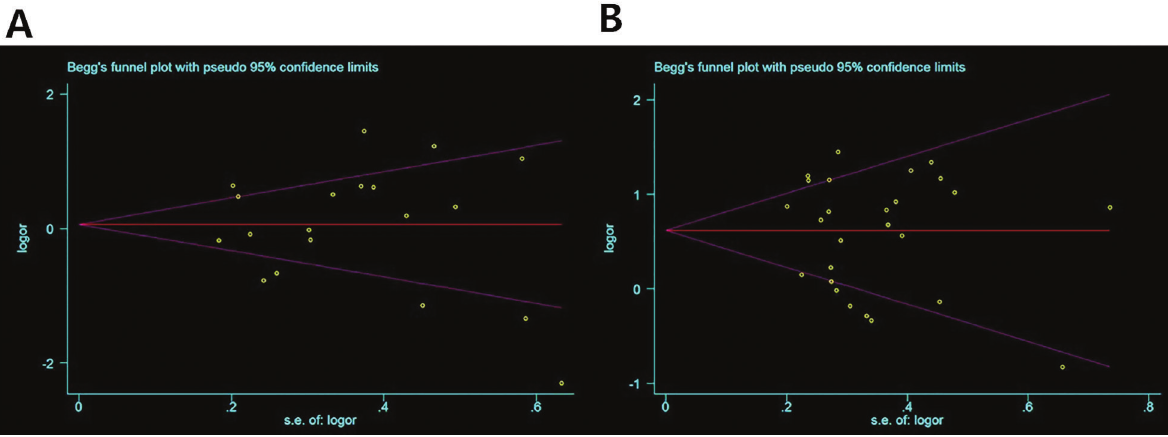
Figure 4. Funnel plots of publication bias for meta-analysis of TNF- a -308 and rheumatoid arthritis (A) and systemic lupus erythematosus (B)